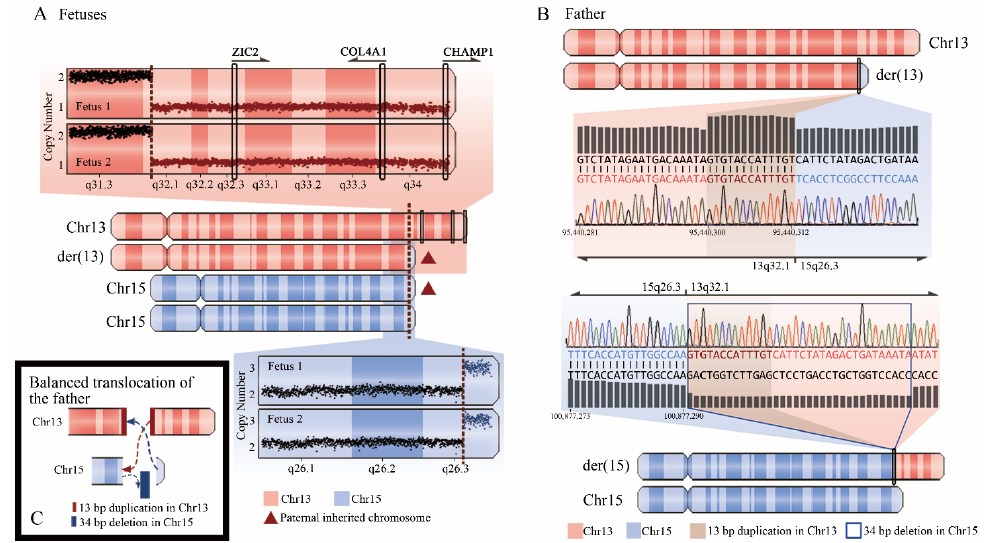
Figure 3. Whole genome sequencing (WGS) identified pathogenic copy number variants (CNVs) in twin fetuses arising from their father’s balanced translocation. ( A ) Distributions of copy number across chromosome 13 and chromosome 15 are shown at the top and bottom, respectively. Dots in red indicate a heterozygous deletion of 19.7 Mb on chromosome 13, and dots in blue indicate a duplication of 1.6 Mb on chromosome 15 in both case 102-1 and case 102-2. The deletion affected three genes that are associated with autosomal dominant developmental disorder. ( B ) The father’s karyotype of chromosome 13 and chromosome 15 are shown at the top and bottom. The distribution of base pair sequencing depth and Sanger sequencing results across the breakpoints on chromosome 13 and chromosome 15 are displayed, respectively, in the middle. There is a templated 13-bp duplication and a 34-bp deletion in the breakpoint junction on chromosomes 13 and 15. ( C ) A schematic drawing of the formation of balanced translocations between chromosomes 13 and 15 in the father.